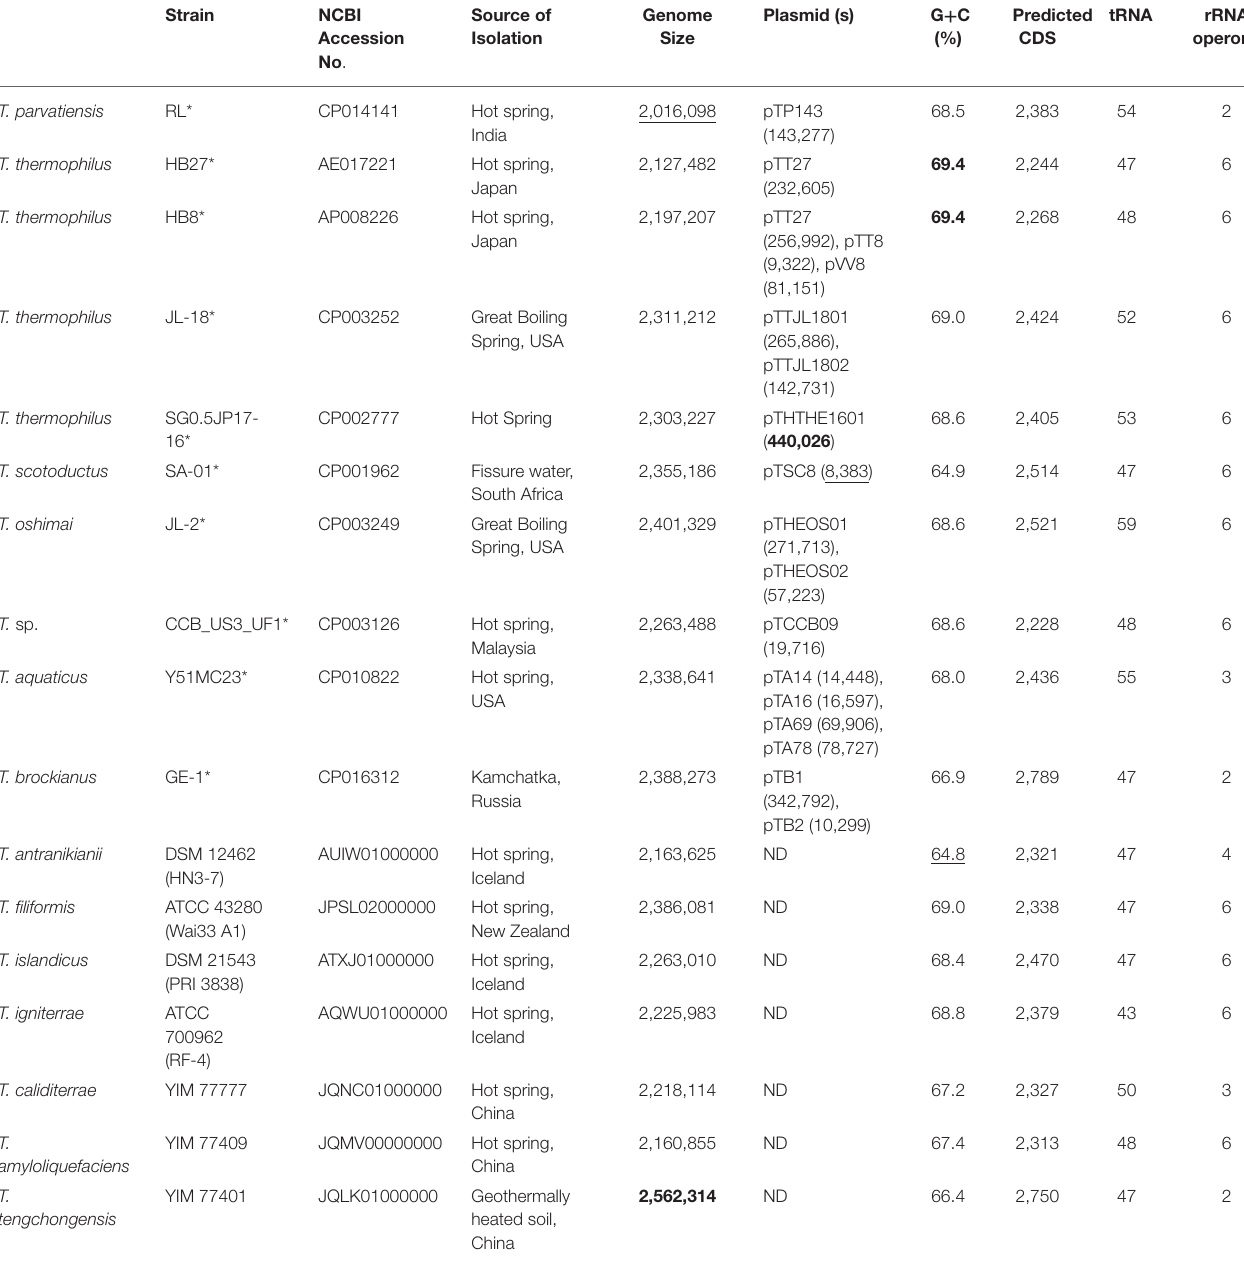
TABLE 1 | General genome features of organisms belonging to the genus Thermus .